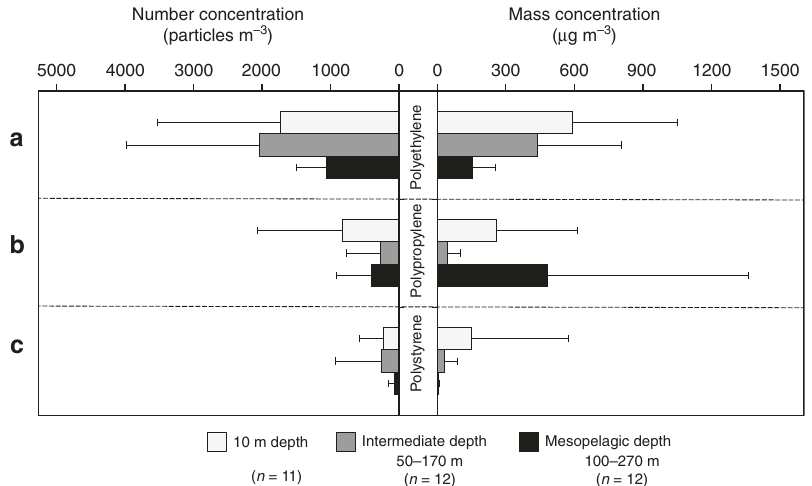
Fig. 4 Vertical distribution of microplastics in the study area. The bars show particle number (particles m − 3 ) and mass concentrations ( µ g m − 3 ) of a polyethylene, b polypropylene and c polystyrene averaged over all sampling stations at each depth horizon. Data presented as mean values with upper error bars ( + 1 s.d.) for clarity. In fi gure legend, letter n in parentheses indicates the number of stations sampled at the respective depth horizon (Supplementary Table 1 and Supplementary Data